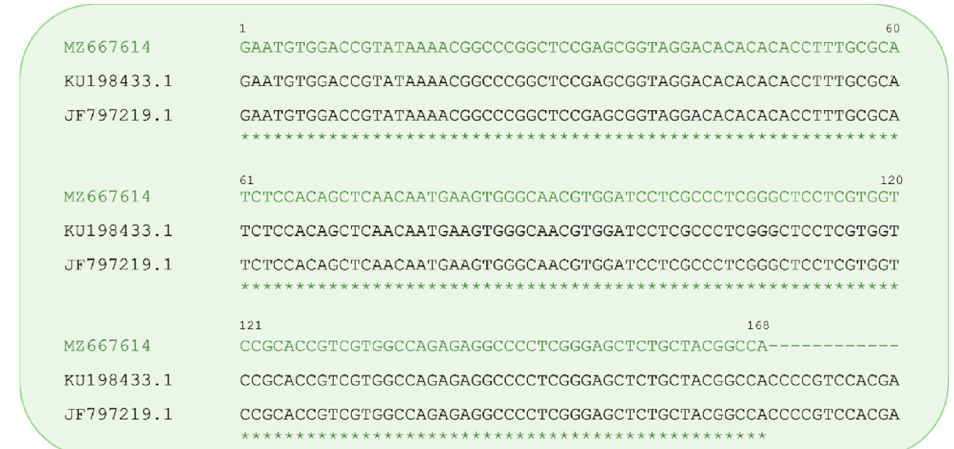
Figure 4. Alignment of the Pseudorabies virus gG sequence from this study (accession n. MZ667614) with related sequences obtained from Canis lupus familiaris (accession n. KU198433.1) and Sus scrofa